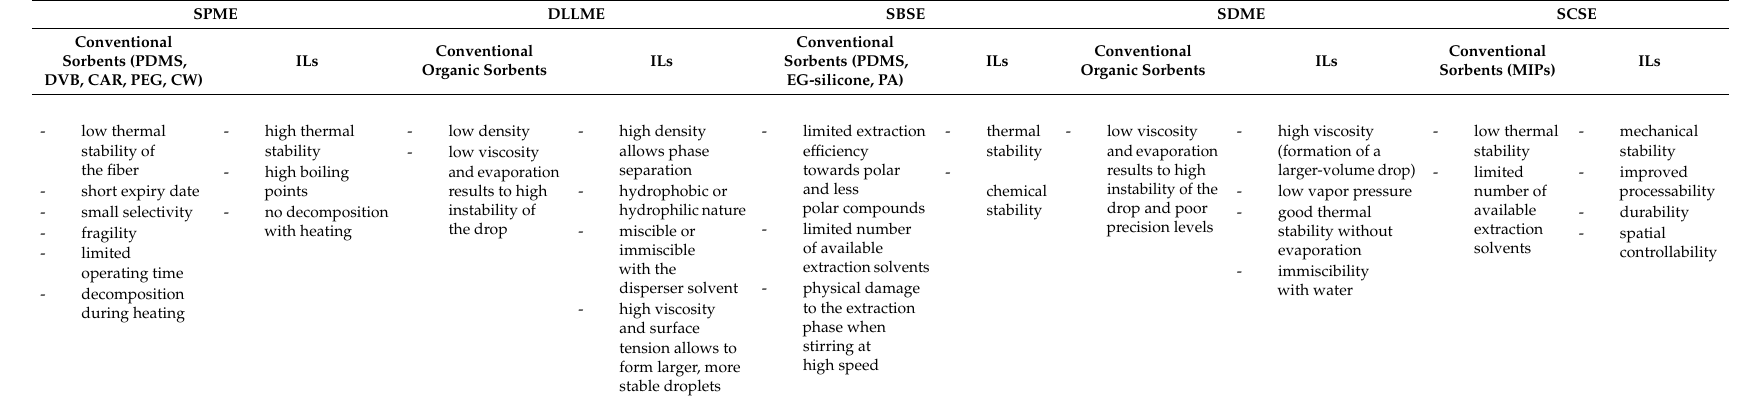
Limitations of the conventional sorbents and superior properties of ILs when they are used in the most commonly used miniaturized microextraction